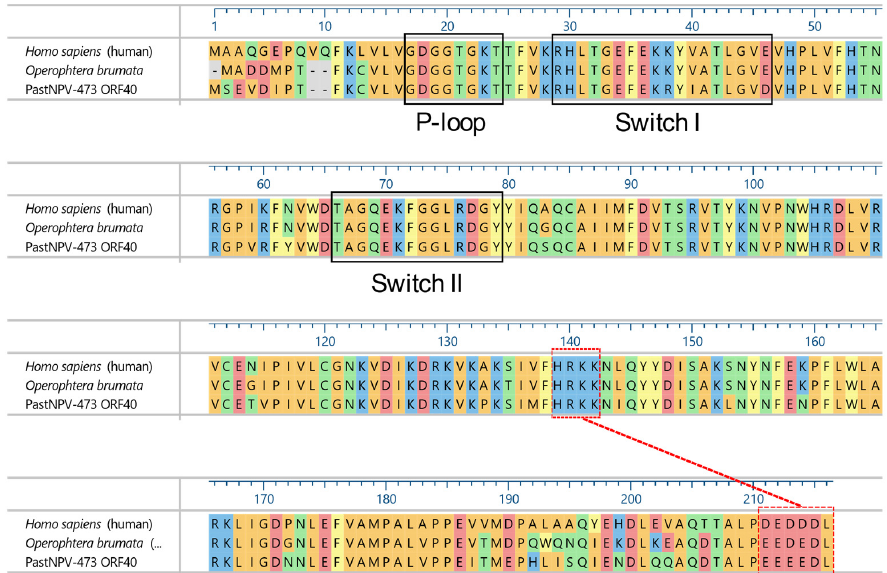
Figure 6. Amino acid sequence alignment of PastNPV-473 ORF40 with human and winter moth ( O. brumata ) homologs of Ran GTPase. Conserved P-loop, switch I, and switch II domains are indicated by black boxes, while a conserved acidic C-terminus (residues 211–216) and the basic patch with which it interacts (residues 139–142) are indicated by red dashed boxes and connecting line.